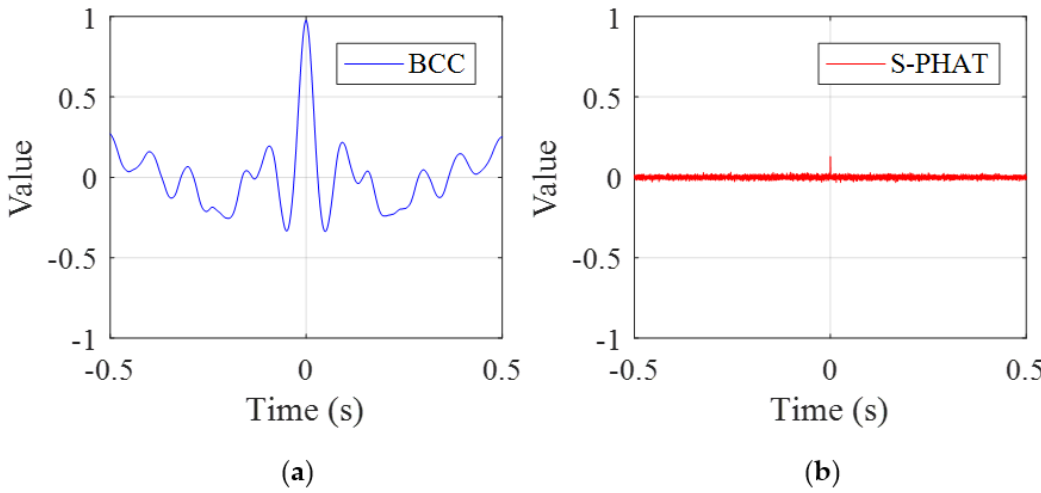
Figure 11. The TDE curves for the test pipe without leakage: ( a ) the BCC method; and ( b ) the secondary PHAT cross-correlation method.